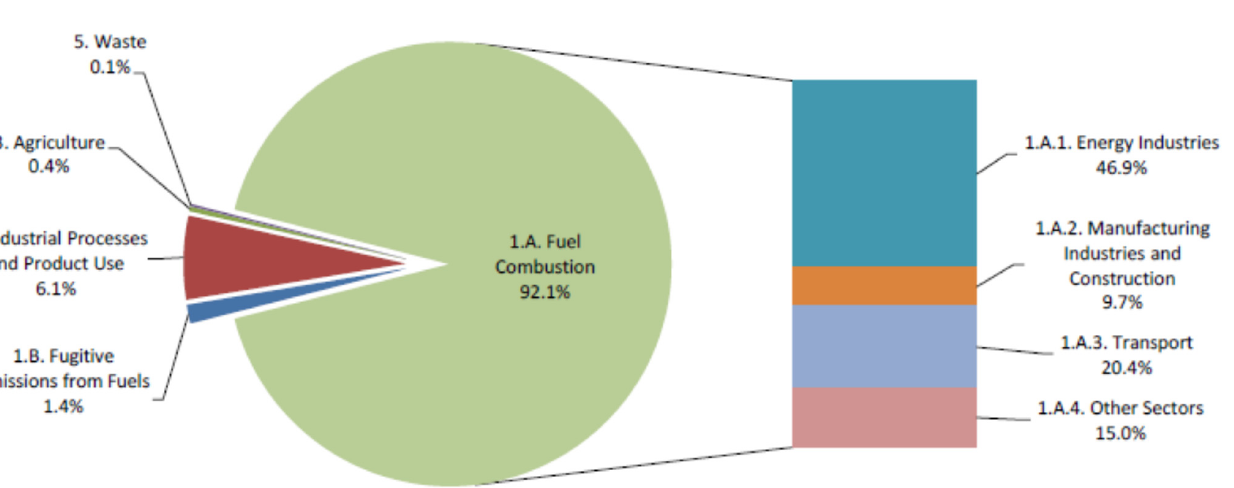
Table 2. Level of CO 2 emissions per capita (in tons) in Poland and other EU countries.